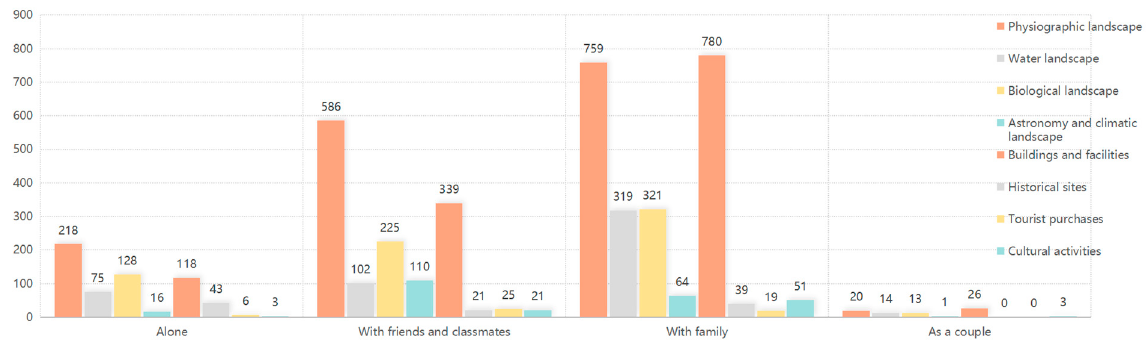
Figure 6. Analysis of tourists’ landscape preferences when using different travel modes.